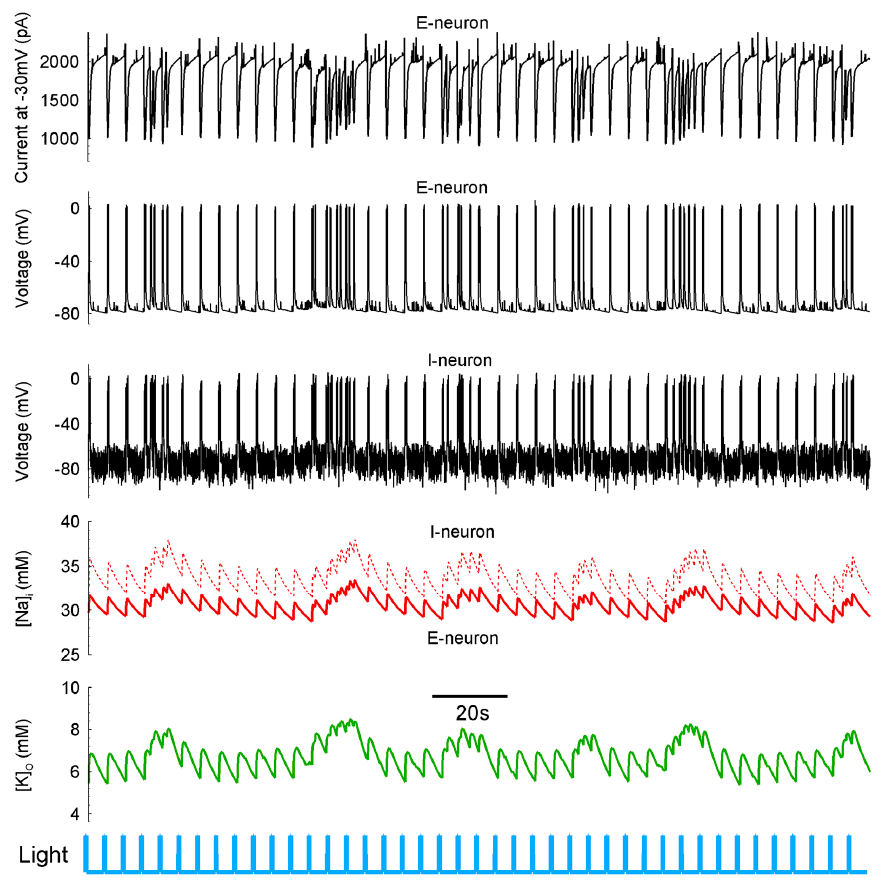
Figure A3. Effect of the LFLS of pyramidal neurons in the mathematical model of epileptiform activity. The control case is presented in Figure 8A. To simulate the effect of LFLS on pyramidal cells, current step pulses with an amplitude 25 pA were injected in excitatory neurons.